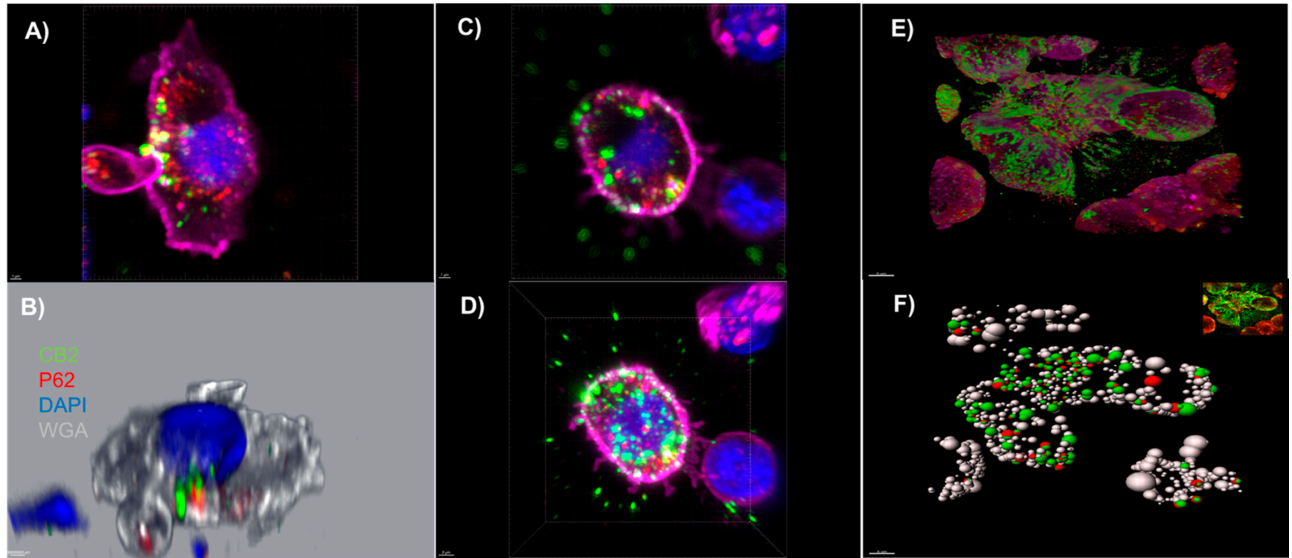
Figure 2. ( A – D ) Confocal light microscopy of CIK cells at day 14 expressing CB2 receptors. Immuno- histochemical staining of CB2 (green), p62 (red), and DAPI (blue). The membrane was stained by Texas-red conjugated wheat-germ-agglutinin (magenta) and DAPI revealed the localization of the nucleus. ( A , B ) Co-localization of CB2 receptors and p62 vesicles at the cell membrane which are in yellow due to the overlap of green and red. 3D reconstruction of confocal images to distinguish the CB2 receptor (green) out of the membrane (grey), and p62 vesicles (red) inside the membrane in close proximity to CB2 receptors; ( C , D ) co-localization of CB2 receptors and p62 vesicles intracellularly. The CB2 receptors have a different distribution in the cell membrane; ( E , F ) confocal light microscopy of PANC-1 pancreatic cancer cell line expressing CB2 receptors. Immunohistochemical staining of CB2 (green), p62 (red). The membrane was stained by Texas-red conjugated wheat-germ-agglutinin (ma- genta). 3D reconstruction modeling of confocal images using a segmentation algorithm to distinguish a single signal from different channels showing co-localization of CB2 receptors and p62